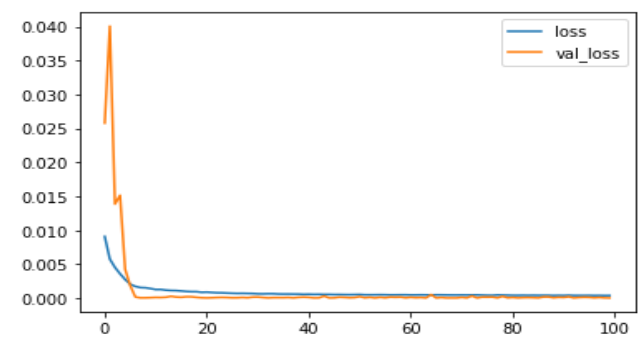
Figure 8. Training and validation losses of LSTM